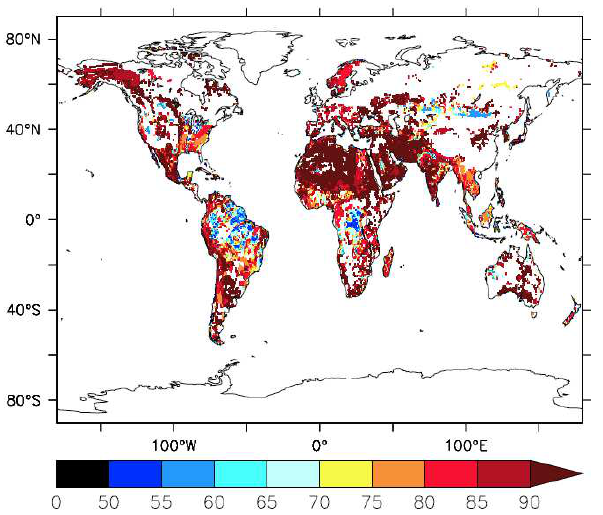
Fig. 4. Illite content in the clay fraction of soils (CASE 1).